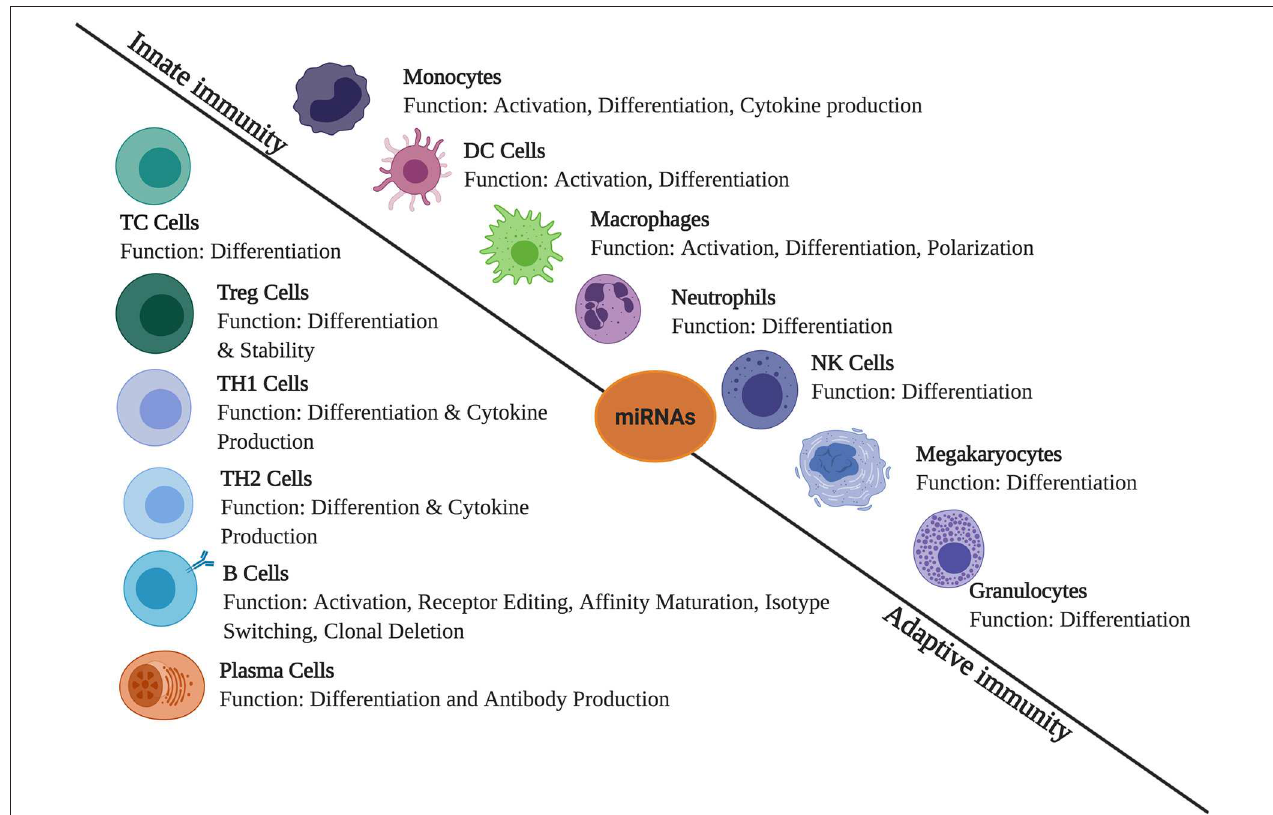
FIGURE 1 | The role of miRNAs in immune regulation. They are expressed in immune cells and play a role in the regulation of innate and adaptive immune responses. They create regulatory networks in innate immunity, regulate functions of immune cells such as monocytes, dendritic cells (DCs), macrophages, neutrophils, natural killer (NK) cells, megakaryocytes, and granulocytes. In adaptive immunity, they also regulate immune signaling pathways involved in the T- and B-cell development, differentiation, central and peripheral tolerance, as well as their